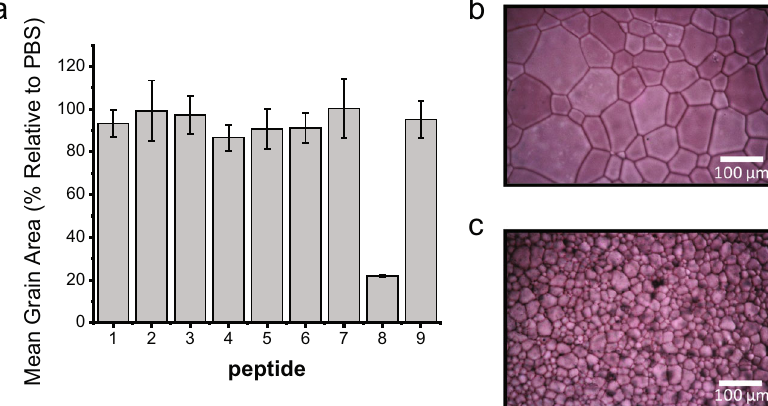
Fig. 3 Ice recrystallization activities of the peptides listed in Fig. 2. a IRI activity of peptides 1 – 9 tested at 1 mg/mL (values reported are averages from three individual experiments shown as mean data values ± SD. Error bars represent standard deviation within the repeats). b , c Representative cryomicrographs of ice crystals grown in the presence of 1 mg/mL of peptide 3 ( b ) and peptide 8 ( c ). Experiments were performed in